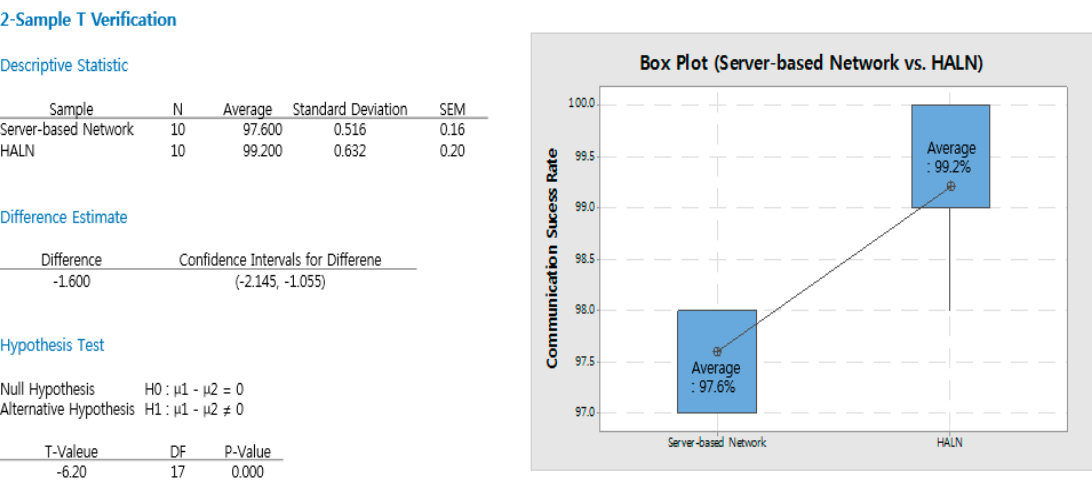
Figure 12. Statistics analysis (2-sample t verification using Minitab) of communication success rates.